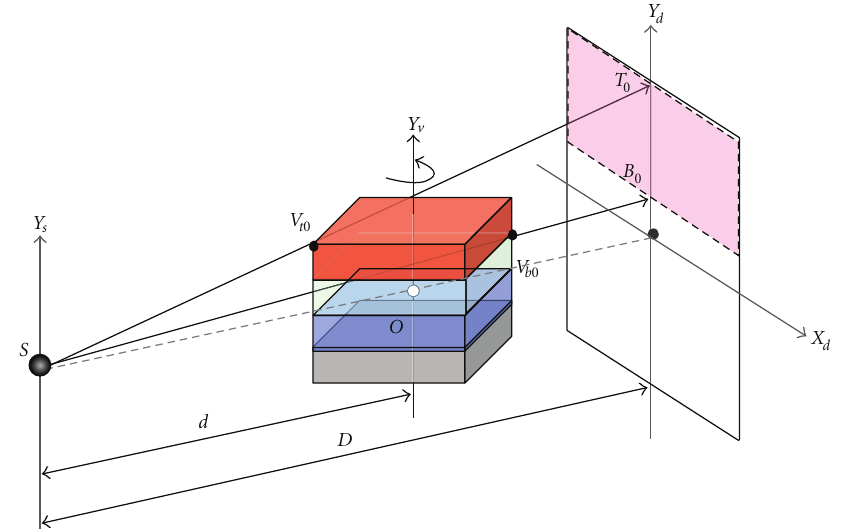
Figure 6: The partitioning scheme of the reconstructed volume and